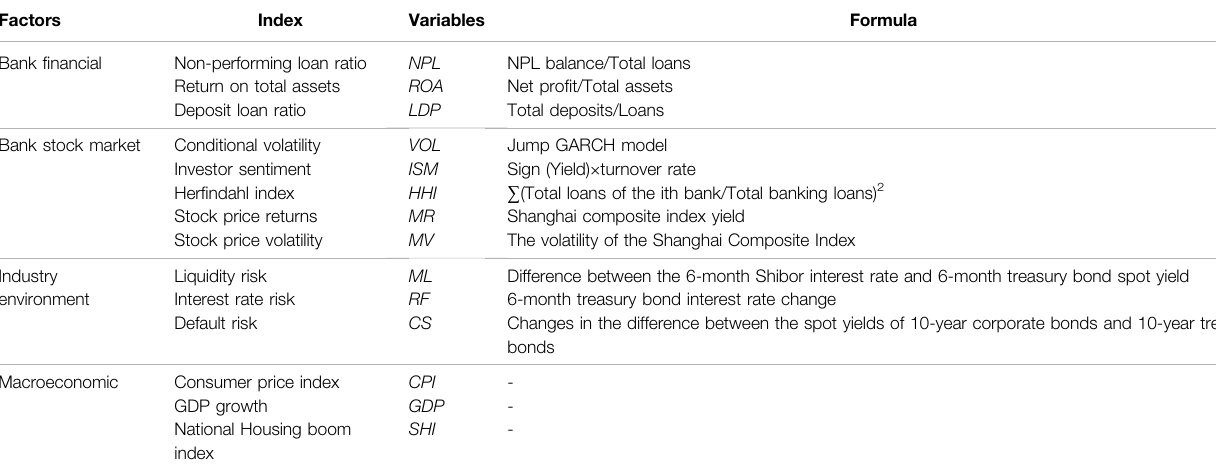
TABLE 1 | Multi-dimensional factor variables of bank risk estimation. Factors